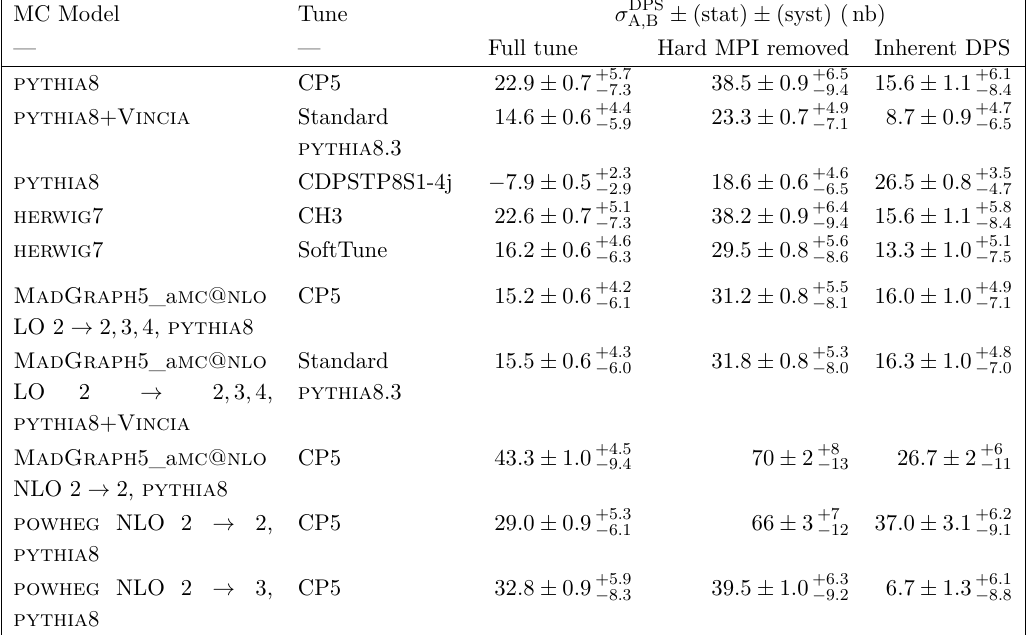
extracted from data using different SPS models, Table 7 . The values of the DPS cross section σ DPS A , B along with their statistical and systematic uncertainties. The results are shown for the model where the full tune is used, and for the same models where the hard MPI have been removed. The last column shows the net difference between the two first columns, and is interpreted as the amount of DPS inherent to the